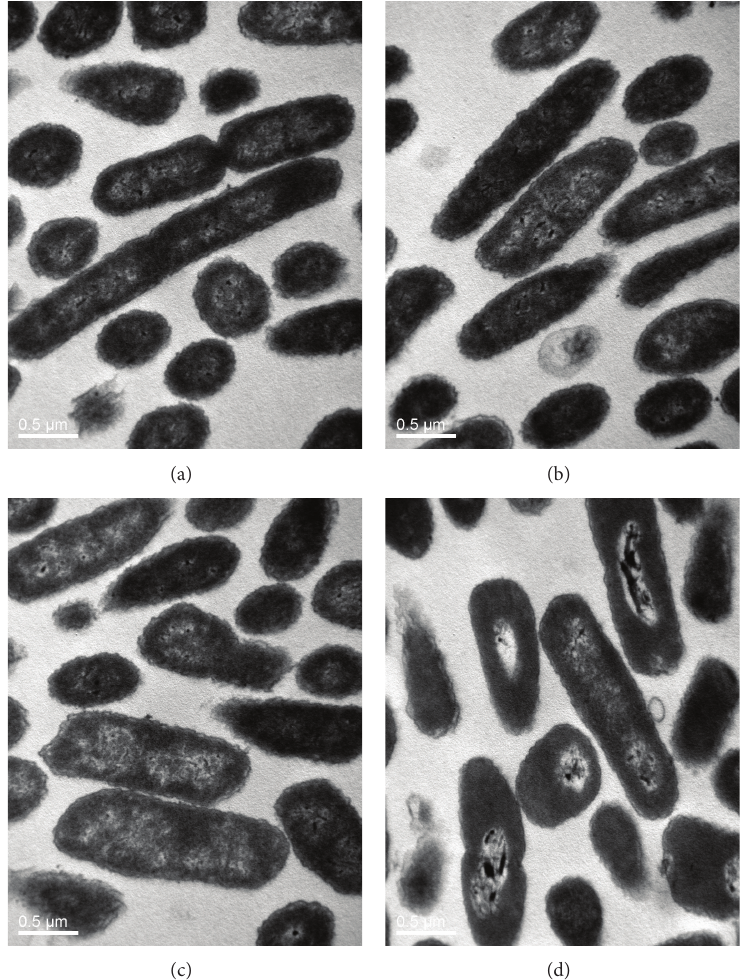
Figure 4: The ultrastructural morphology of E. coli cells was observed under a transmission electron microscopy (TEM) after photodynamic action of hypocrellin B (25 𝜇 M), in which the energy density of blue light was 12 J/cm 2 . (a) Sham control; (b) hypocrellin B treatment alone; (c) blue light irradiation alone; and (d) photodynamic treatment of hypocrellin B ( × 30000).